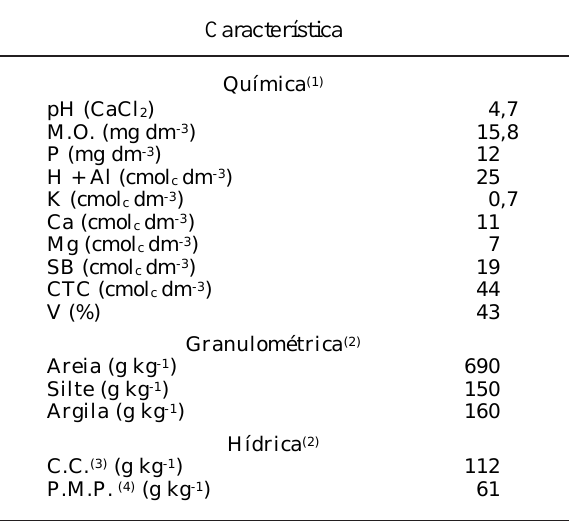
Figura 1. Ilustração esquemática dos vasos utilizados no